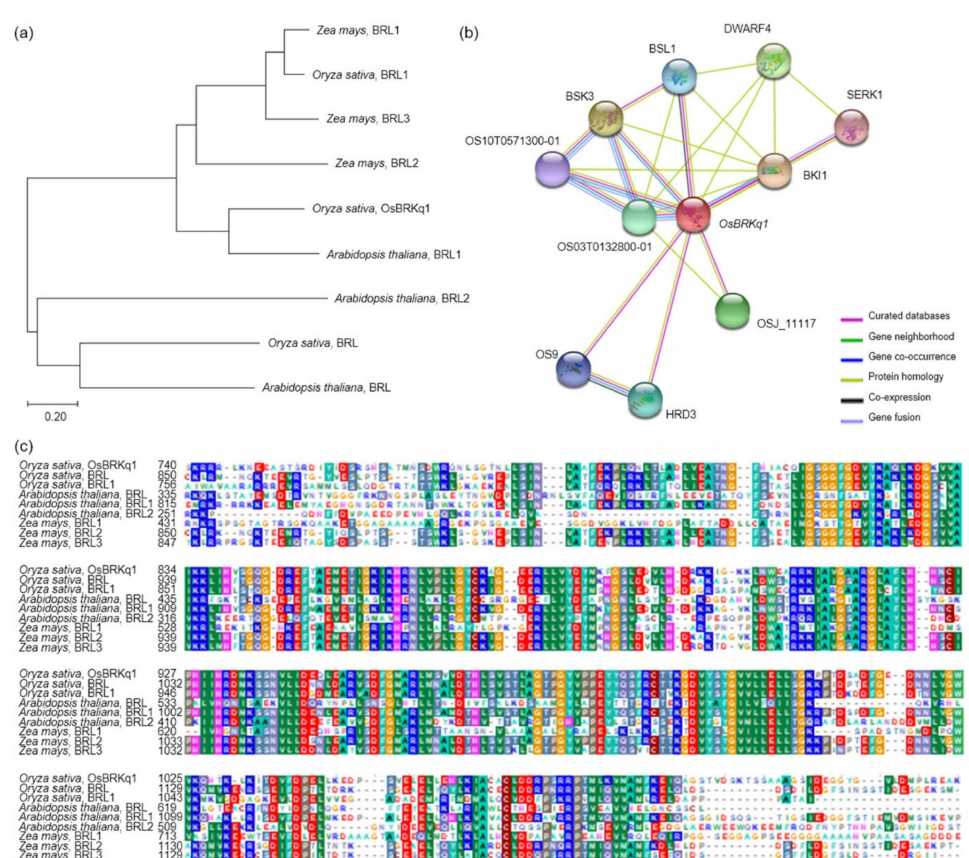
Figure 6. Sequence analysis of OsBRKq1 . ( a ) Analysis of the relationships of the OsBRKq1 gene and analysis of a homologous gene, using a phylogenetic tree that was constructed using 1000 bootstrap replicates. ( b ) Various proteins interacted with OsBRKq1 . Brassinosteroids (BRs) regulate the growth and development all of plants. BRs regulate various pathways, such as the development of grain size, ethylene biosynthesis, and proton secretion into the cell wall. All of these proteins are related to the BR biosynthesis pathway. ( c ) Conserved domain of the protein sequences of homologous genes of OsBRKq1 ; very high similarity was observed in Oryza sativa , Arabidopsis thaliana , and Zea mays